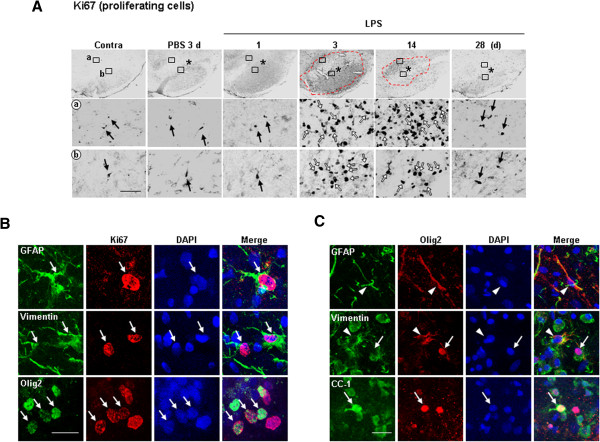
Ki-67 immunoreactivity was found in astrocytes and oligodendrocytes in LPS-injected SNpc. (A) Brain sections were prepared at the indicated times after LPS-, and PBS-injection and stained with antibodies specific for Ki-67. Lower panels are higher magnification of boxed areas in upper panels. In intact contralateral (contra) sides and sections from PBS-injected brains, some Ki67+ cells were detectable (black arrows). Dotted lines at 3 and 14 d show areas where the number of Ki67+ cells dramatically increased (whiter arrows). Asterisks (*) indicate injection sites. (B) Sections obtained at 3 d were double-labeled with combinations of Ki-67/GFAP, Ki-67/Vimentin, and Ki67/Olig2 antibodies. Nuclei were labeled with DAPI. Arrows indicate cells co-labeled with Ki67 and each cellular marker. (C) Sections obtained at 7 d were double-labeled with combinations of Olig2/Vimentin and Olig2/CC-1 antibodies. Arrowheads and arrows indicate cells where Olig2 was found in the cytosol and nuclei, respectively. Scale bars, 200 μm (upper panels in A), 50 μm (lower panels in A), and 20 μm (B, C).